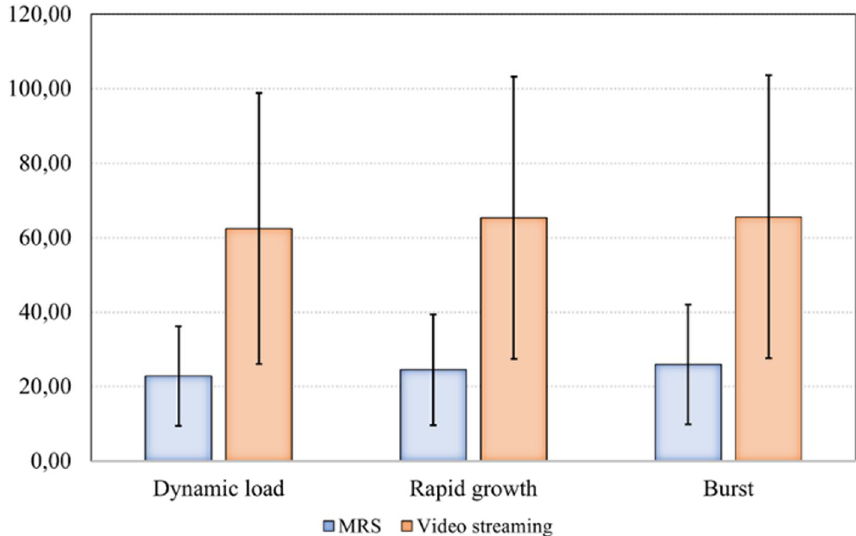
Fig. 12 The mean price (USD) and standard deviation for the application services and workload